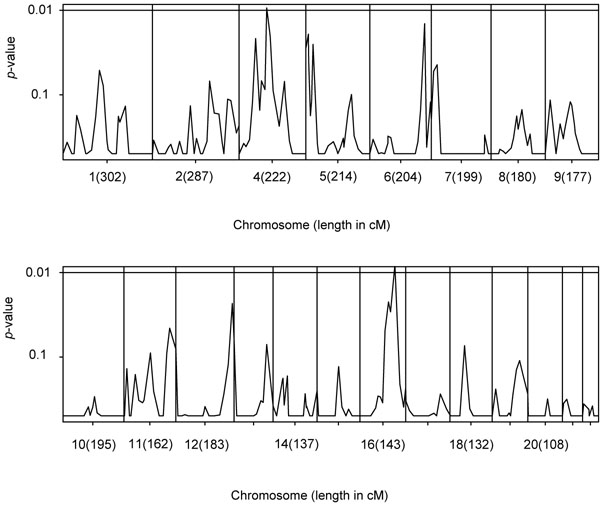
p-Values for the score statistic throughout the genome